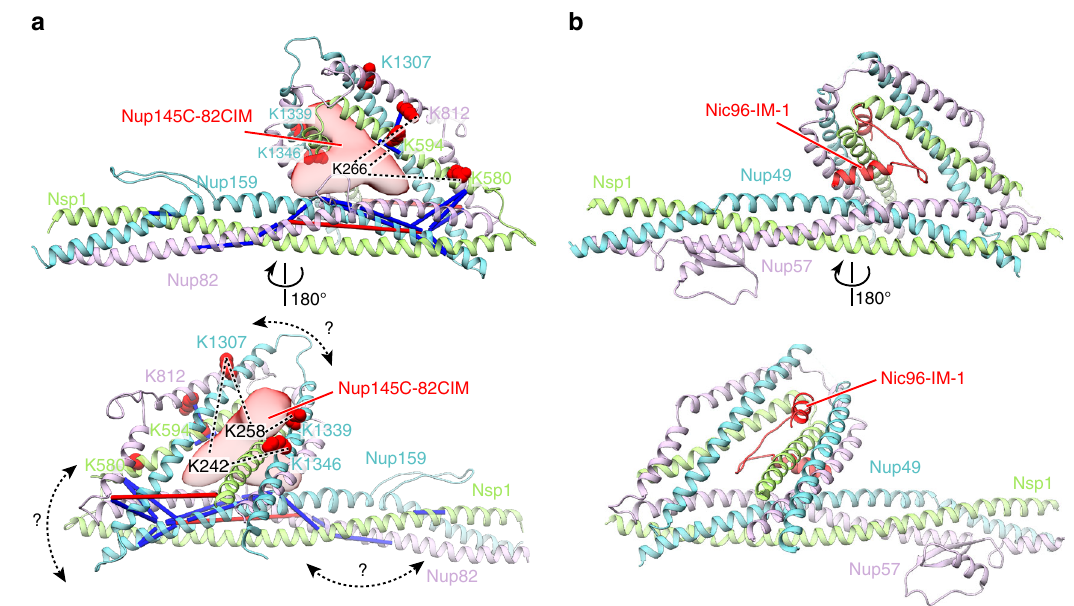
Fig. 5 XL-MS suggests that Ct Nup145C binding to the Ct Nup82 complex resembles Ct Nic96 binding to the Ct Nsp1 complex. The model of the Ct Nup82 complex a was built based on the Ct Nsp1 complex ( b , PDB ID: 5cws). The Ct Nup145C-82CIM motif (residues 215 – 270), which could not be reliably modeled at the atomic level, is shown as a low-resolution density. Note that although sequence similarity suggests that the Ct Nup82 complex has an architecture similar to the Ct Nsp1 complex; the exact orientation of the coiled-coil domains might be different (curved double arrows). Residues crosslinked to Ct Nup145C-82CIM are shown as red spheres and the crosslinked residues of Ct Nup145C are marked as K242, K258, and K266. Crosslinks between Ct Nup82, Ct Nsp1, and Ct Nup159 are indicated as sticks, crosslinks to Ct Nup145C as dashed lines. Crosslinks that satisfy the distance threshold of 30 Å are colored blue, and red otherwise. The two violated (red) crosslinks ( Ct Nup159 Lys1249- Ct Nup82 Lys710 and Ct Nsp1 Lys649- Ct Nup82 Lys769) have relatively low ld-scores of 25.3 and 28.46, respectively. They thus might be false positives, in line with the calibrated FDR of 5% for the entire XL-MS data set. Alternatively, fl exibility or alternative arrangements of coiled-coil domains might account for the distance